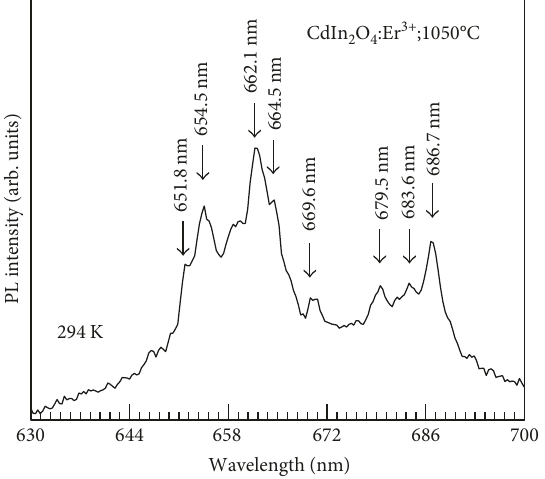
Figure 4: Photoluminescence spectrum of CdIn the range from the 630 to 700nm at 294 K.